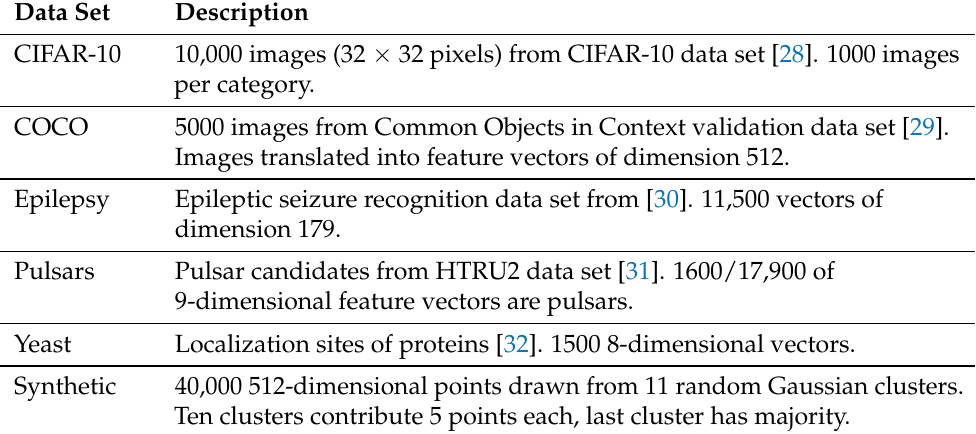
Table 1. Data sets